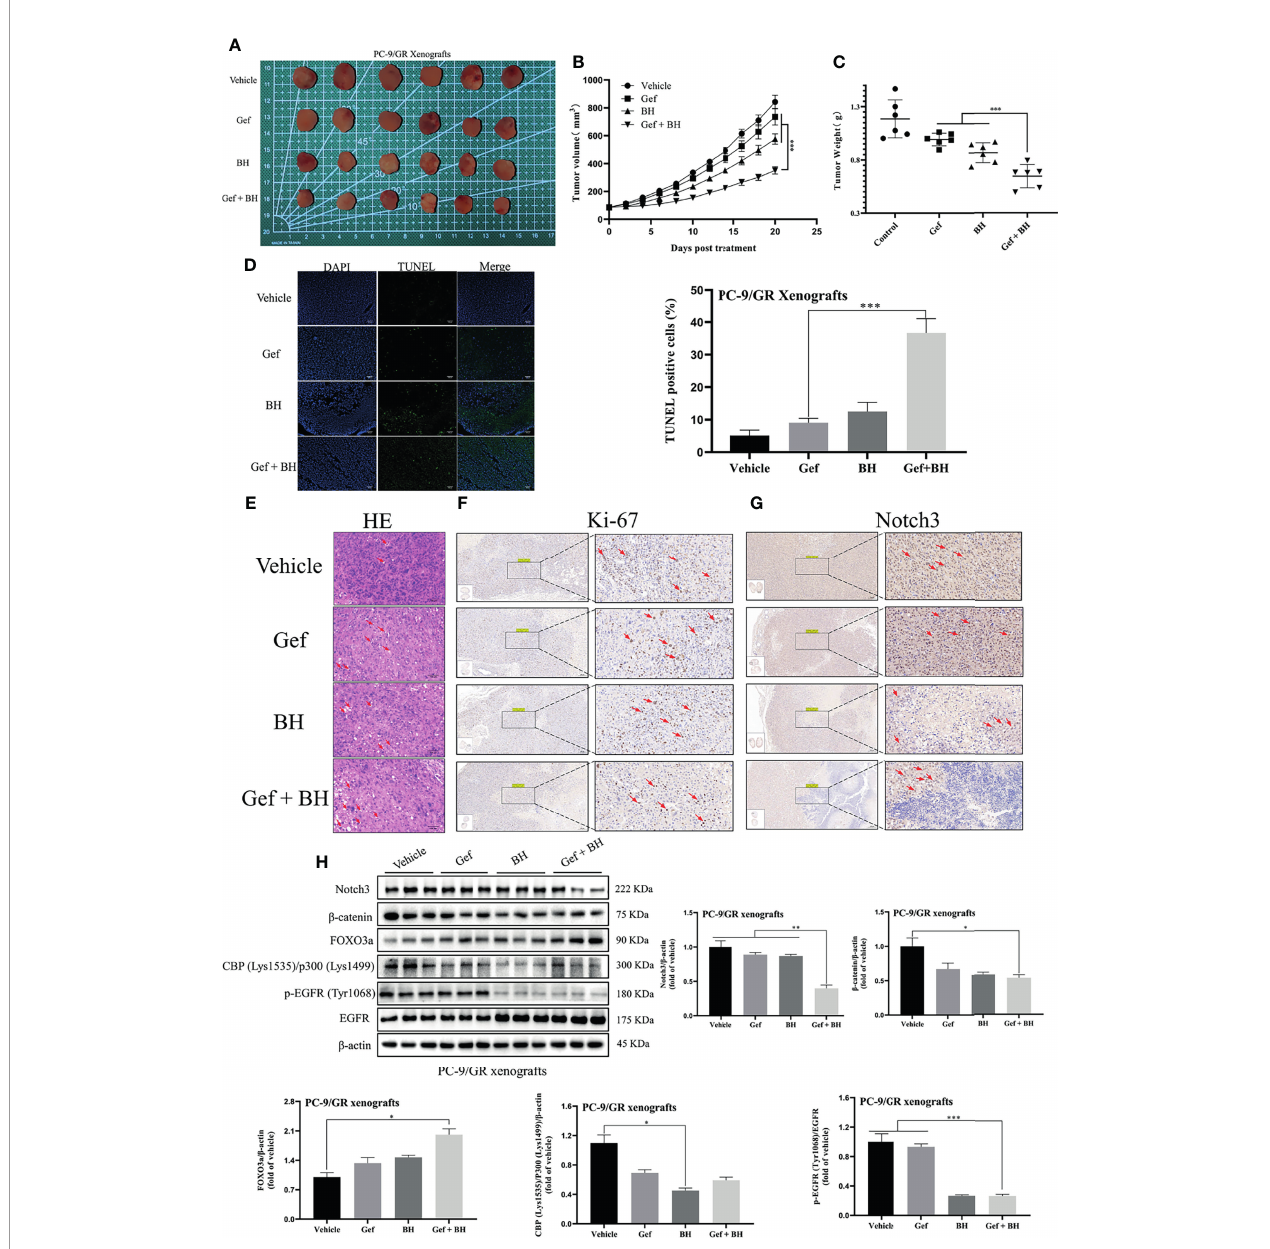
FIGURE 8 | Combination of BH and ge fi tinib suppressed the growth of PC-9/GR xenografts tumor. (A) Representative pictures of tumors. n = 6 per group. (B) Tumor volume of PC-9/GR xenografts. (C) Tumor weights and size of PC-9/GR xenografts. (D, E) TUNEL assay and H&E staining were performed to examine histological morphology and apoptosis of tumor tissues, and the scale bar was 100 m m. (F, G) The protein levels of Ki-67 and Notch3 of PC-9/GR xenografts were detected by IHC, and the scale bar was 200 m m. (H) The expressions of Notch3, b -catenin, FOXO3a, p-EGFR (Tyr1068), EGFR, and BPC (Lys1535)/P300 (Lys1499) of PC-9/GR xenografts were measured by Western blot. “ * ” represents Gef +BH group, BH group, Gef group vs. the group (*p < 0.05, **p < 0.01, ***p<